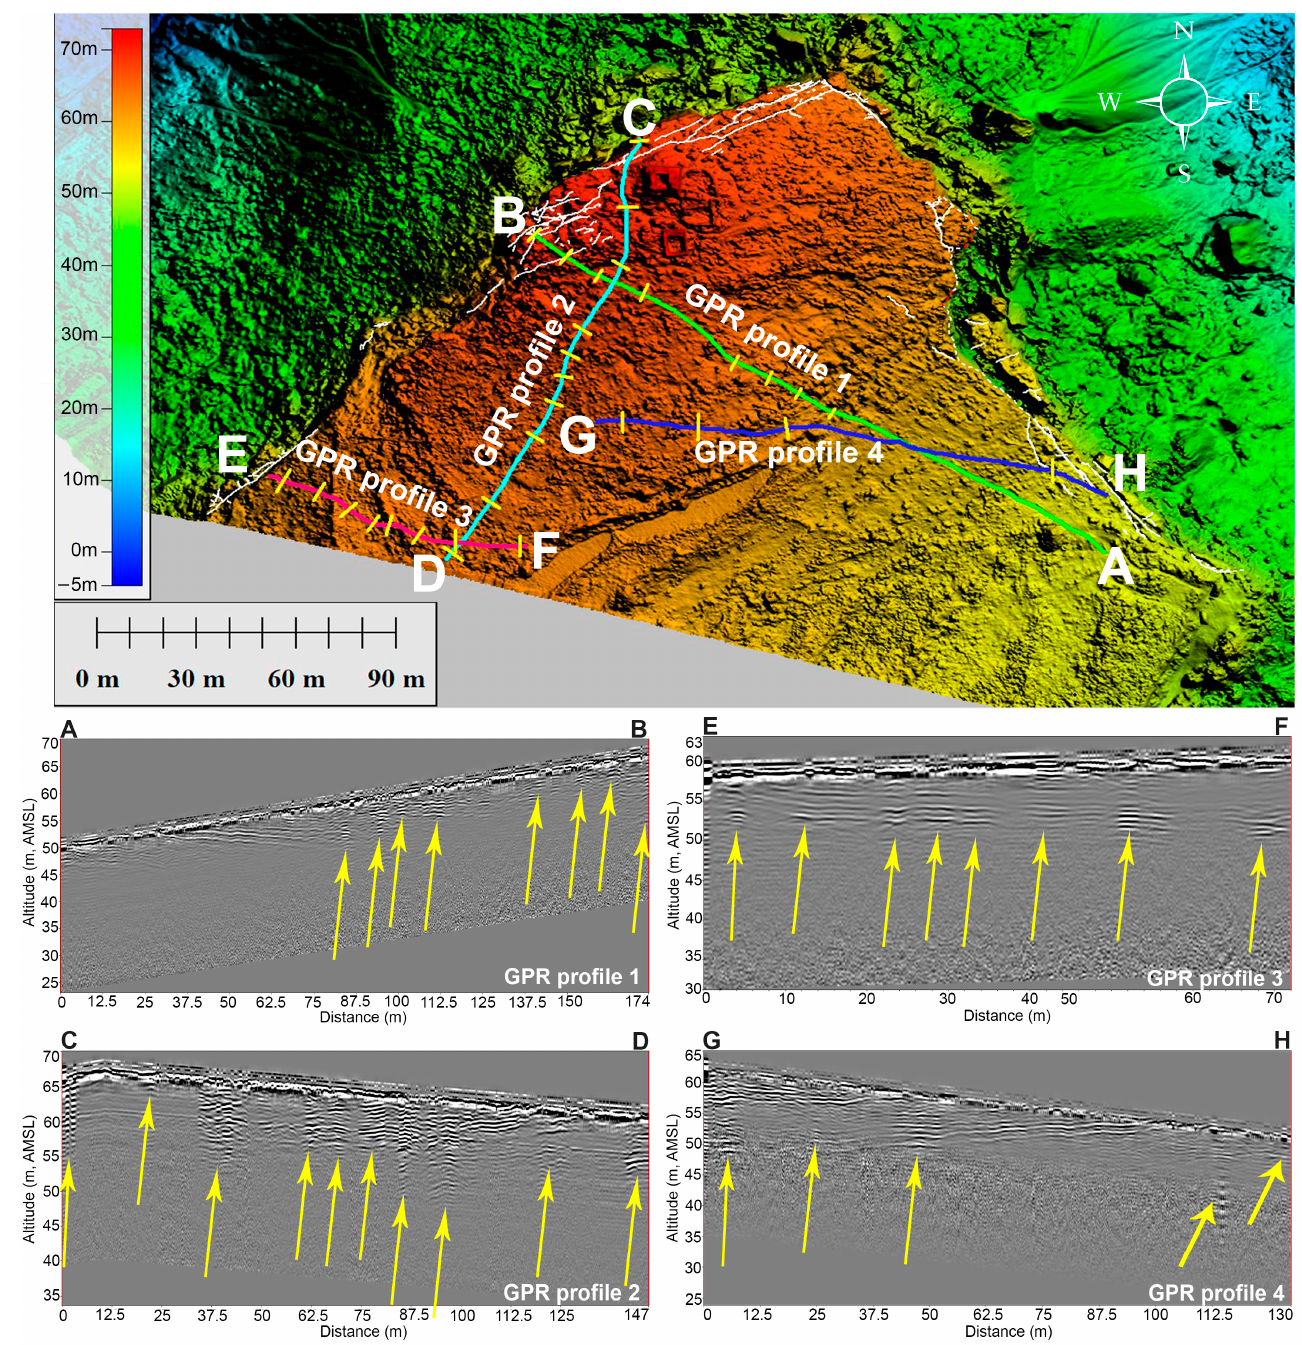
Figure 7. On the top part of this figure, the GIS project with the DEM overlayed by the georeferenced paths of the four GPR profiles is visible. The white polylines superimposed on the DEM are the visible fractures from the surface, while the yellow lines represent the georadar anomalies interpreted as vertical fractures. The second half of this figure shows the processed B-scans of the four GPR profiles (A-B, C-D, E-F and G-H) and the yellow arrows indicate the vertical fractures.